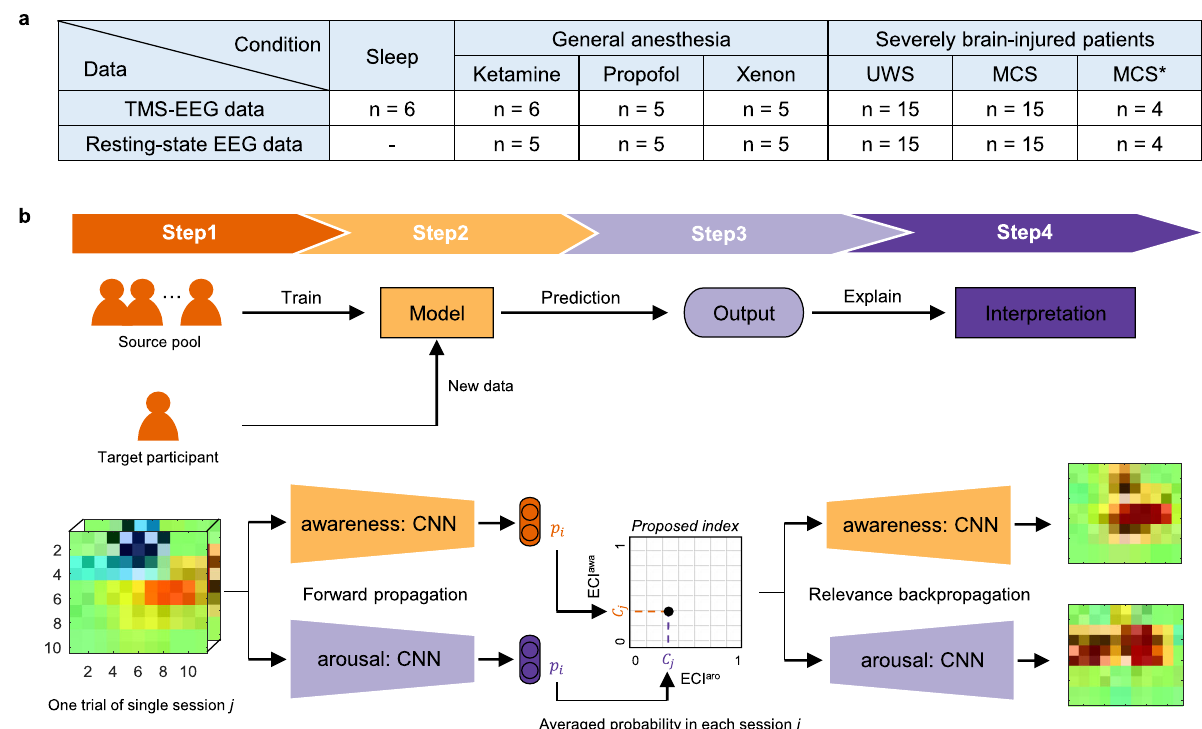
Fig. 1 Overview of the study. a Data description. The same participants participated in transcranial magnetic stimulation-induced electroencephalography (TMS – EEG) and resting-state electroencephalography (EEG) measurements. The sleep condition did not include resting-state EEG, and one participant under ketamine-mediated anesthesia was missing in resting-state EEG. b Schematic framework for determining the explainable consciousness indicator (ECI). In step 1, raw EEG signals were converted into a spatio-spectral or spatiotemporal 3D matrix. In step 2, the converted 3D feature was used on a trained as two classes (low versus high). For example, for awareness, rapid eye movement (REM) sleep with subjective experience (i.e., dreaming) and